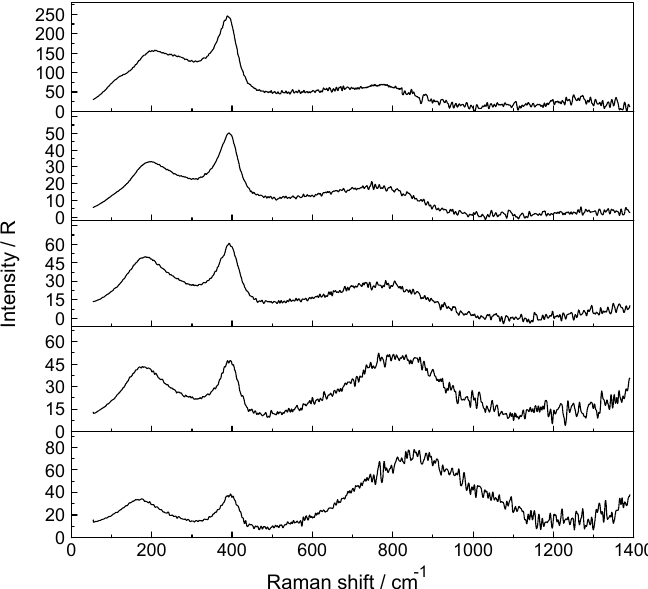
Figure 5. Isotropic Raman scattering profiles of aqueous LuCl 3 solutions: from top to bottom: 3.199 mol·L − 1 (R w = 15.68), 1.890 mol·L − 1 (R w = 28.51), 0.935 mol·L − 1 (R w = 98), 0.478 mol·L − 1 (R w = 116) and 0.241 mol·L − 1 (R w = 229.86). The Lu-O mode in the most concentrated solution (3.199 mol·L − 1 ) at 390 cm − 1 compares to the one at 396 cm − 1 in a 0.241 mol·L − 1 LuCl 3 (aq). This slight frequency shift is due to the substitution of Cl − into the first hydration sphere, forming [Lu(OH 2 ) 7 Cl] 2+ . The broad feature at ~254 cm − 1 is assigned to [Lu(OH 2 ) 7 Cl] 2+ . See also Figure 4A,B.